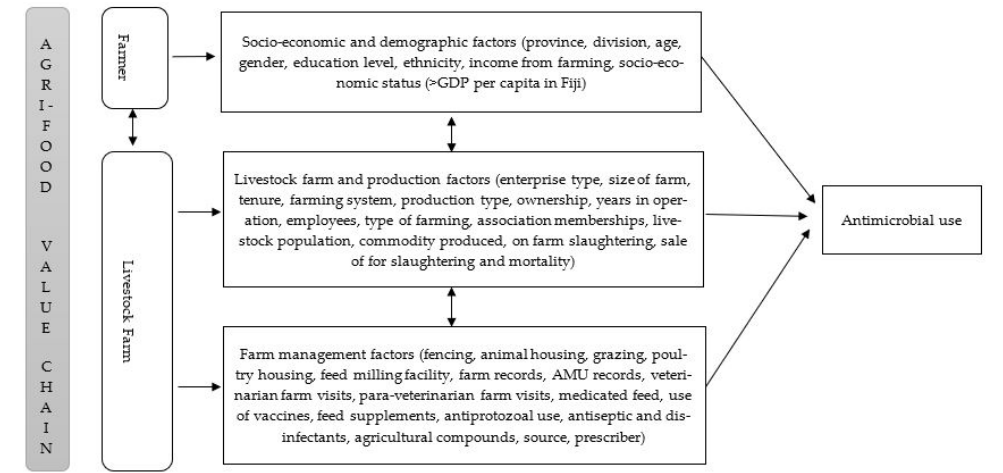
Figure 1. The conceptual framework illustrating the overarching constructs influencing antimicrobial use.